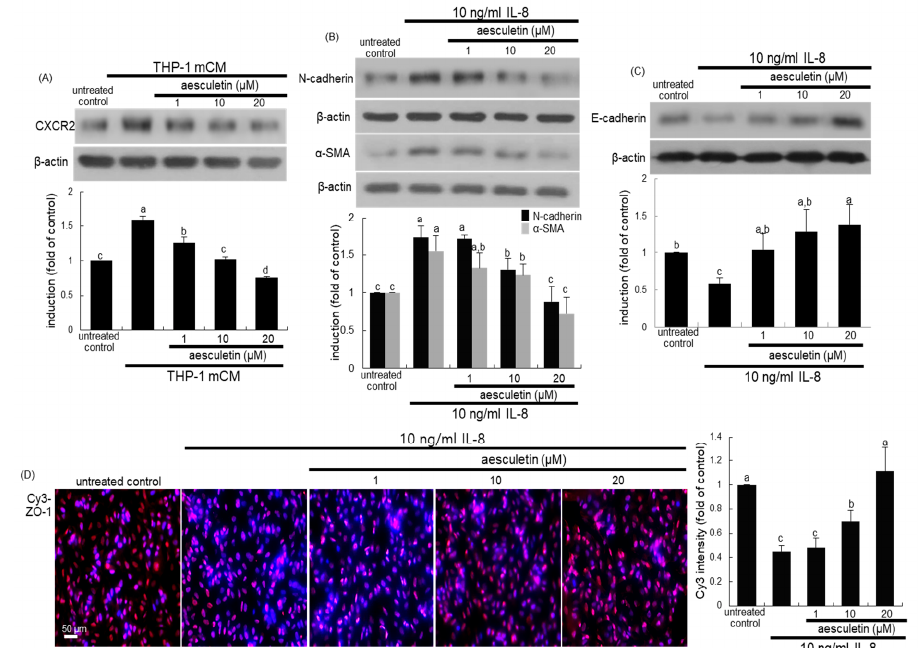
Figure 5. Inhibitory e ff ects of aesculetin on CXC-chemokine receptor 2 (CXCR2) induction ( A ) by THP-1 monocyte-derived conditioned media (mCM) and induction of epithelial–mesenchymal transformation (EMT) markers by IL-8 ( B – D ). A549 cells were treated with 1–20 μ M aesculetin in mCM or in the presence of 10 ng/mL IL-8 for 24 h. Cell lysates were subject to Western blot analysis with a primary antibody against CXCR2, N-cadherin, α -SMA, and E-cadherin ( A – C ). The bar graphs (mean ± SEM, n = 3) represent quantitative results of the upper bands obtained from a densitometer. Alveolar epithelial ZO-1 of A549 cells was identified as Cy3-red staining ( D ). Nuclear counter-staining was conducted with 4 ′ ,6-diamidino-2-phenylindole (blue). Fluorescent intensity of Cy3-red staining was measured using an optical Axiomager microscope system (mean ± SEM, n = 3). Respective values in bar graphs not sharing a common letter indicate significant different at p < 0.05. Scale bar = 50 μ m.